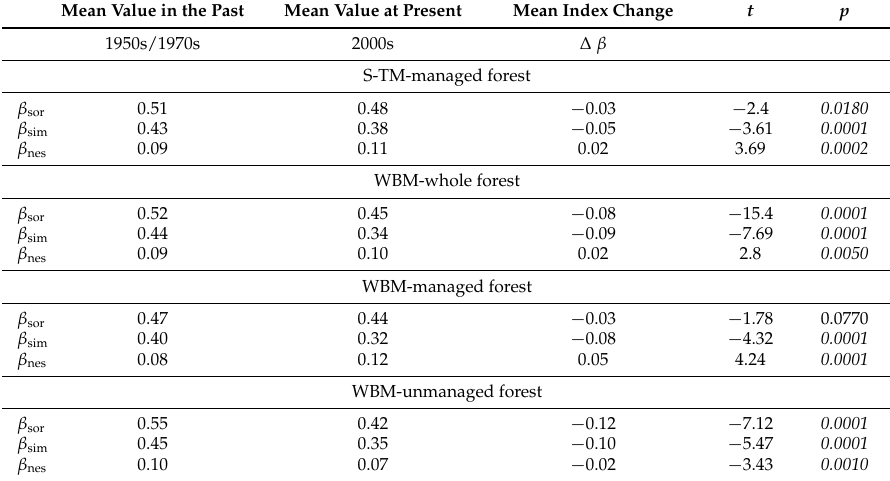
Table 2. The mean values of species diversity for the first and second inventory and the changes in species composition dissimilarity in the investigated part of the Sanocko-Turczanskie Mountains and the Western Bieszczady Mountains between the 1950s/1970s and 2000s in managed and unmanaged forests. S-TM-managed forest: n = 66; WBM-whole forest: n = 62; WBM-managed forest: n =